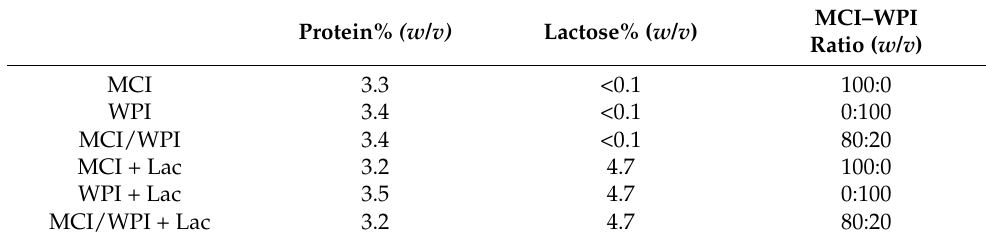
Table 2. Model study specifications of MCI, WPI and its mixtures with lactose.